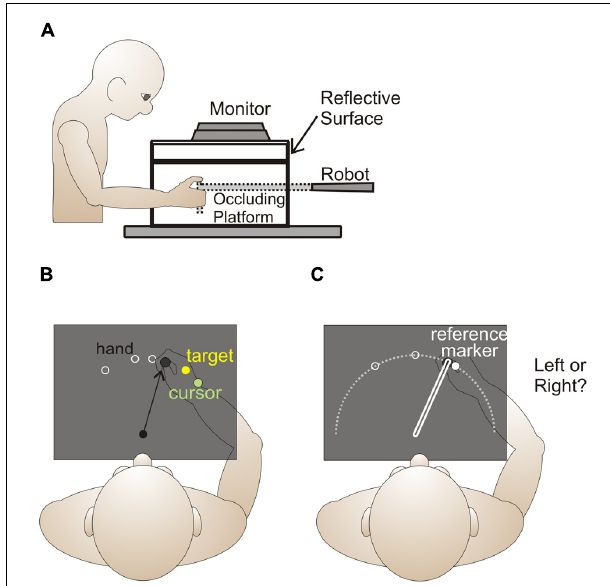
FIGURE 1 | Experimental setup and design. Side (A) and top (B,C) view of experimental setup. (B) For both reaching training trials and no cursor reach trials, reach target locations, 1 cm in size, (locations indicated by the white rings) were 10 cm from the home position (shown as a black circle), and were 5 ◦ and 30 ◦ left and right of the body midline. In reach training trials, visual feedback of the unseen hand was provided by displaying a green cursor at the end of an initial reach in order that subjects could obtain the target (yellow circle). During the first rotated training block, the green cursor, representing the hand, was gradually rotated to 30 ◦ clockwise, and remained at this magnitude for the rest of the task and throughout the remaining two blocks. (C) Hand-proprioceptive estimate task.Trials started from a home position, which was illuminated by a 1 cm dot for 500 ms. After the home position disappeared, subjects pushed their hand out along a robot-guided constrained linear path (white rectangle on right) to a location on the white arc (not shown to subjects) relative to 1 of 3 possible reference markers (locations indicated by white circles) 10 cm from the home position.The reference markers, which appeared only after the hand had finished its outward movement, were 1 cm in diameter and located at 0 ◦ and 30 ◦ left and right of the body midline. Subjects were required to indicate if their hand was left or right of the reference marker.